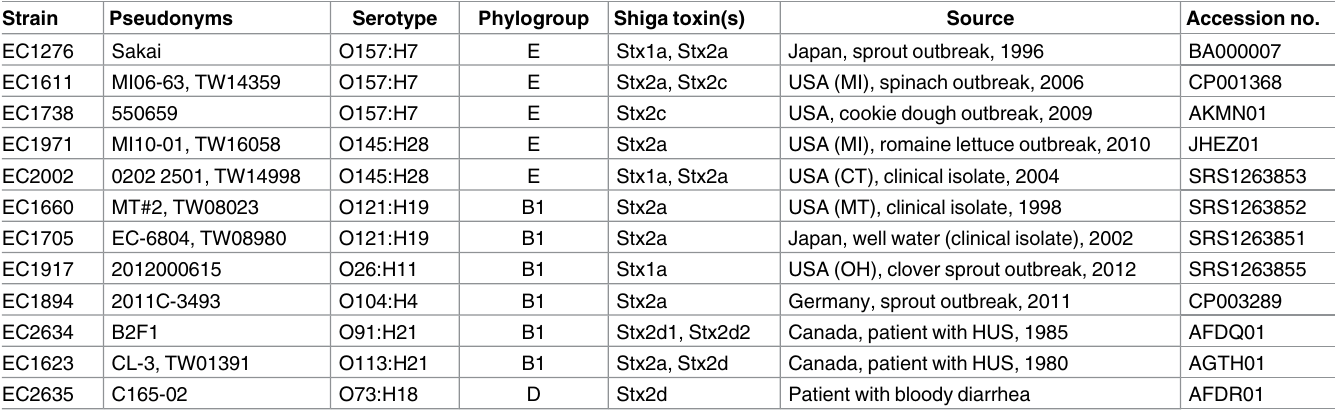
Table 1. Characteristics of STEC strains included in this